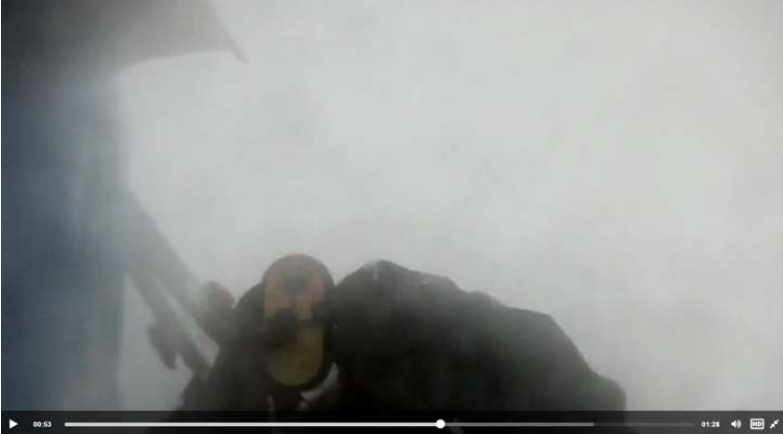
Figure 6. Still from the video “ Is that a ski pole? ”